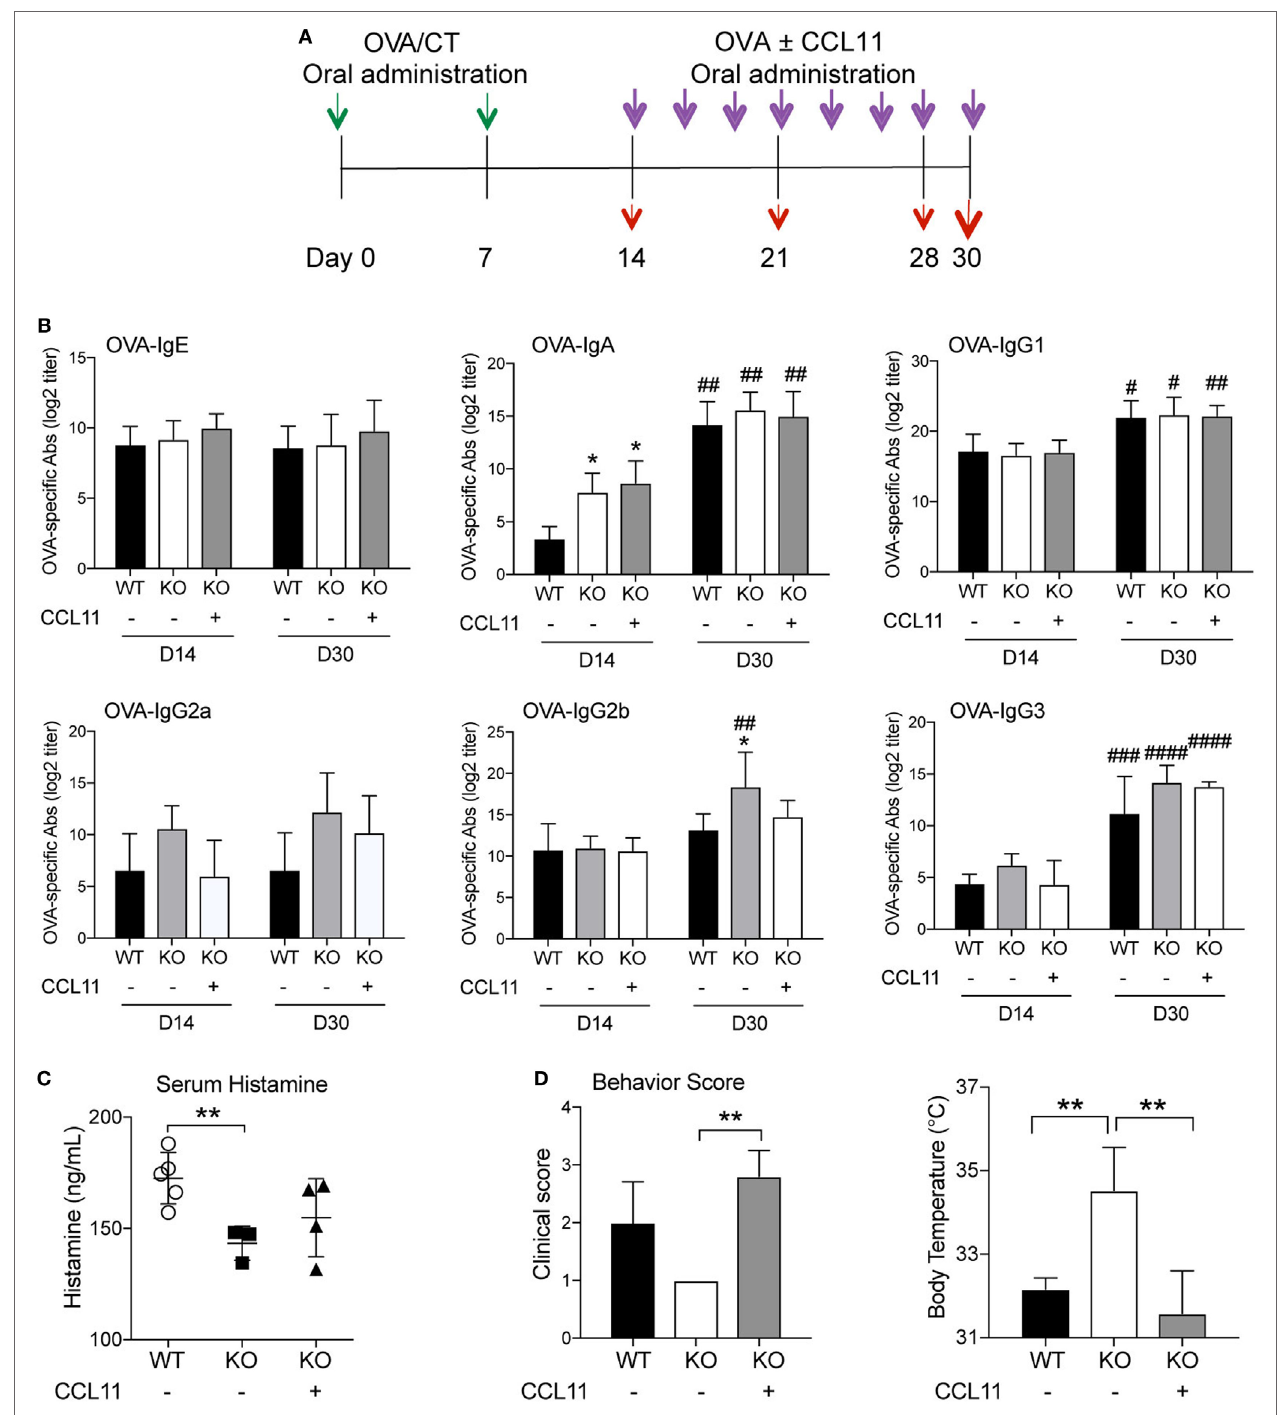
FigUre 6 | Oral CCL11 at the time of allergen challenge restores allergic responses in IKK β Δ IEC mice. (a) Experimental scheme. Oral sensitized IKK β Δ IEC mice with ovalbumin (OVA) and CT (green arrows) were orally administered OVA allergen with or without recombinant CCL11 protein (purple arrows). Serum or lung tissues were collected at days 14, 21, 28, and 30 to analyze antibodies responses or clinical signs of allergy (red arrows). (B) Allergen-specific serum Ab responses. Serum samples were collected on days 14 and 30 and OVA-specific Ab titers were determined by enzyme-linked immunosorbent assay. Data are expressed as mean ± SD. * p < 0.05; ** p < 0.01 when compared to wild-type (WT). # p < 0.05, ## p < 0.01; ### p < 0.001; #### p < 0.0001 compared today 14. (c) Serum histamine levels, (D) clinical scores, and surface body temperature after oral allergen challenge with OVA. Data are expressed as mean ± SD. * p < 0.05; ** p < 0.01 ( n = 5